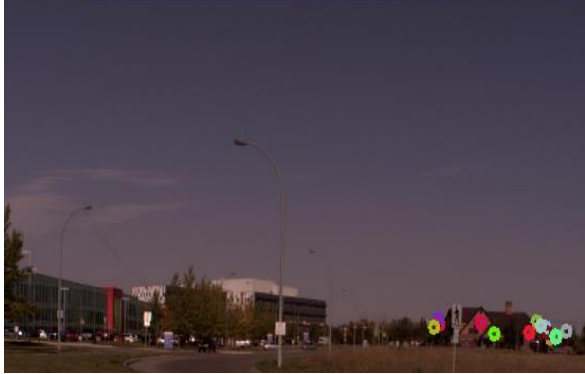
Figure 2. Image taken by the ILRIS Camera associated with the second scan In Figure (3), the result of point cloud registration is zoomed in to show the scale of the building. The RGB colour points are the registered point cloud and the intensity colour points are the reference point cloud.